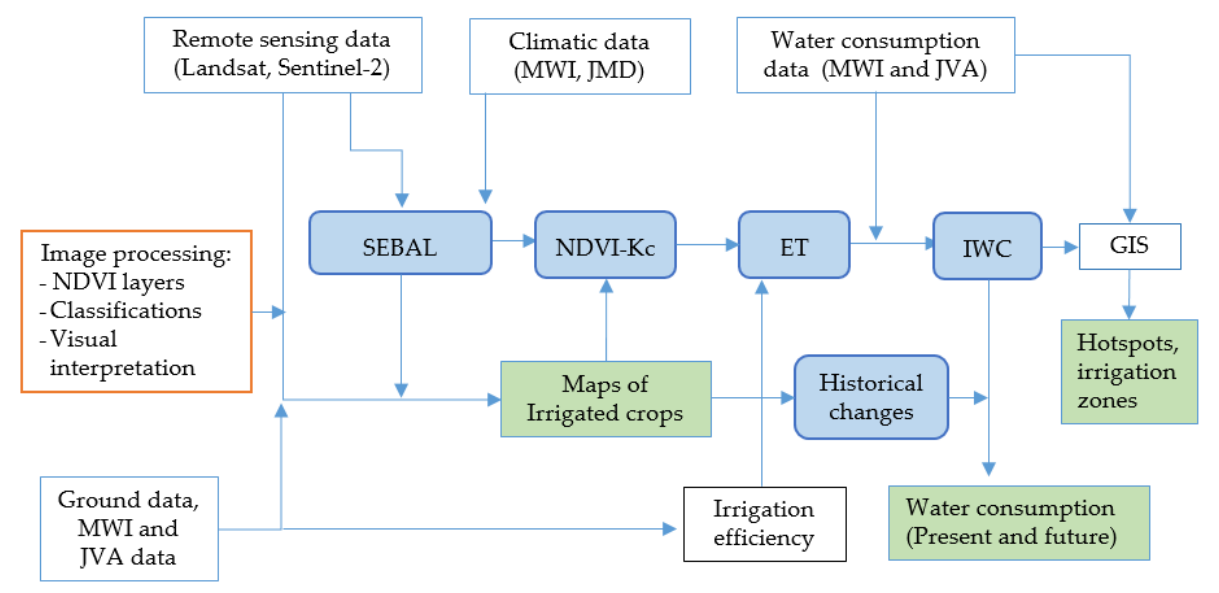
Figure 2. Flowchart of the study methodology.